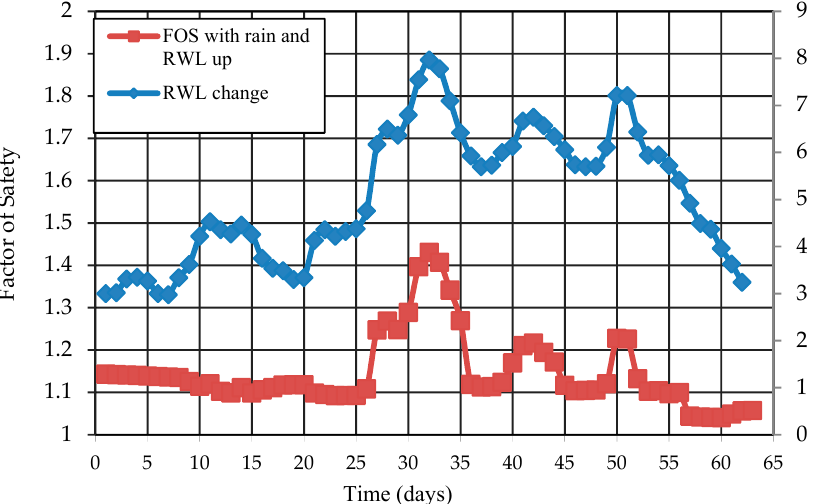
Figure 14. The FOS change with fluctuations of RWL and rainfall in the long-term.